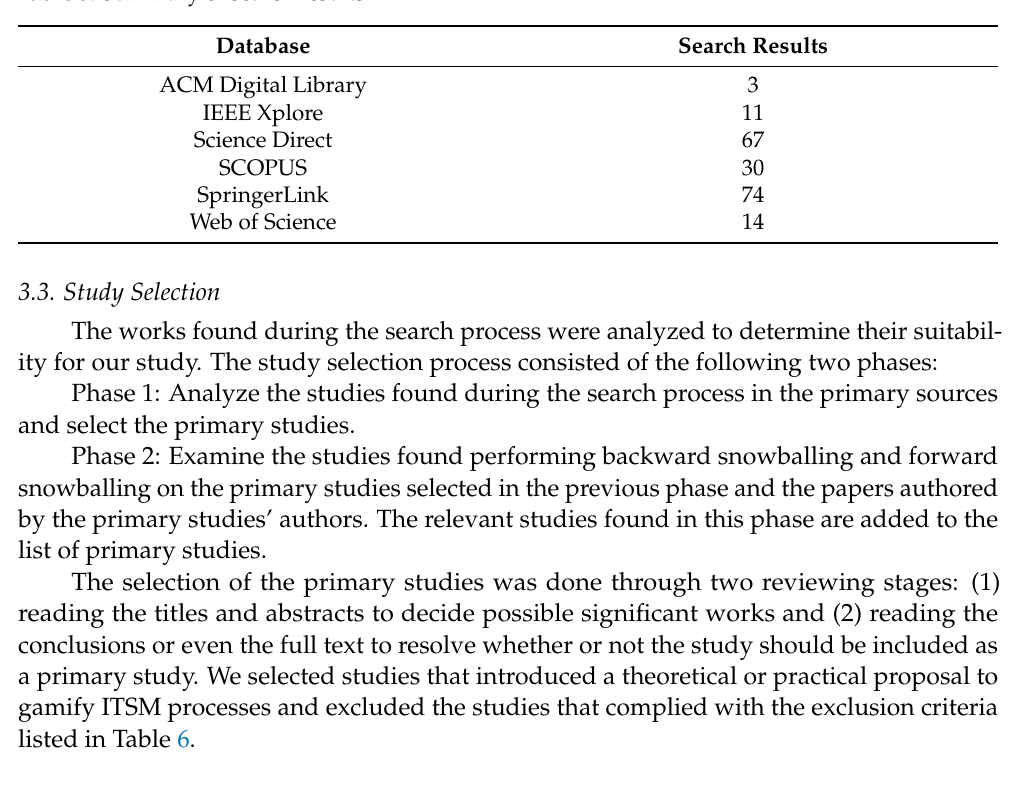
Table 5. Summary of search